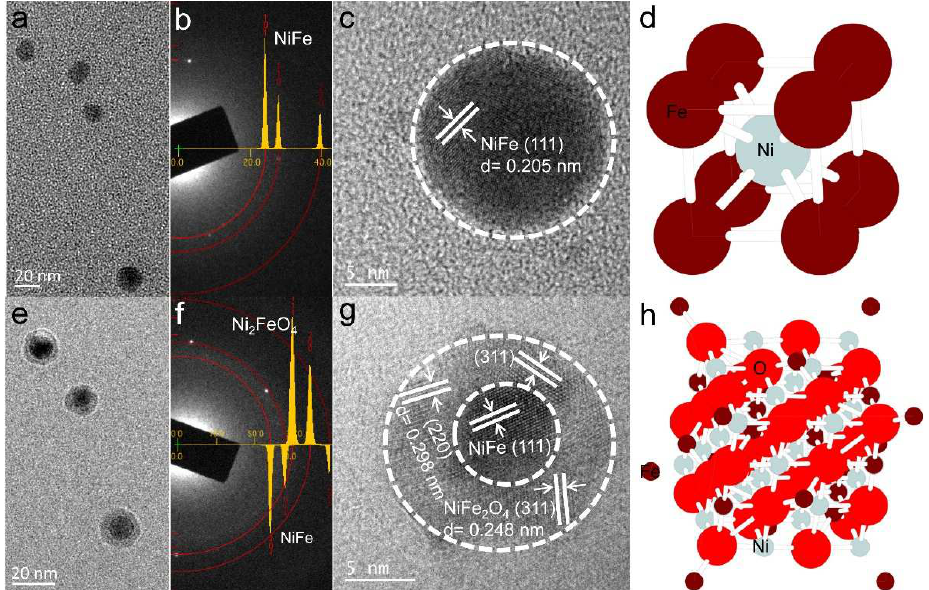
Figure 1. ( a , e ) lanar low magnitude TEM images, ( b , f ) electron diffraction patterns, ( c , g ) HRTEM images, ( d , h ) unit cell schematic diagrams of NiFe nanoparticles and NiFe/NiFe 2 O 4 core/shell nanoparticles in amorphous Al 2 O 3 matrix, respectively.